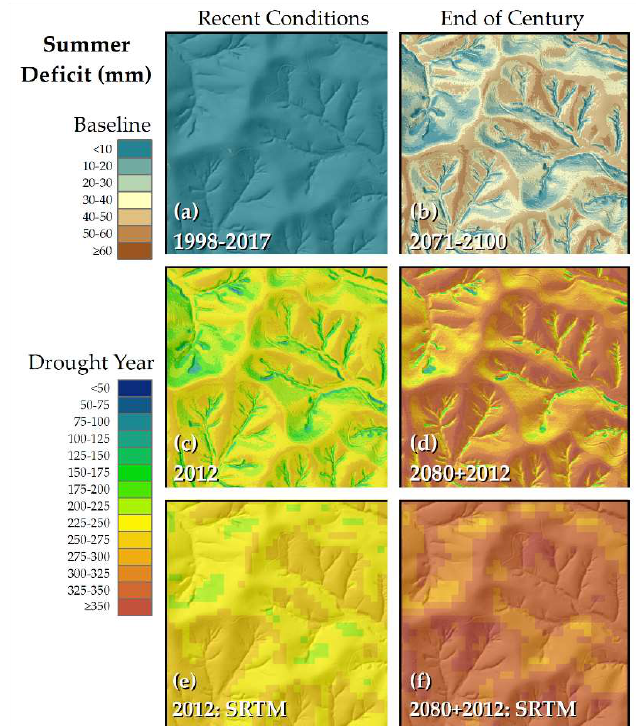
Figure 2. Modeled summer (JJA) water deficit for Lilly–Dickey Woods. Depicted area measures 900 m × 900 m, centered on the 25-ha ForestGEO plot. Left panels represent simulations of recent observed climatic conditions, right panels are comparable simulations for end-of-21st century climatic projections derived from the RCP8.5 radiative forcing scenario: ( a ) baseline conditions using average monthly values, 1998–2017; ( b ) baseline conditions with projected changes for 2071–2100 (“2080”); ( c ) drought year 2012; ( d ) projected future changes applied to 2012 values; ( e ) same historical simulation as ( c ) using NASA Shuttle Radar Topography Mission (SRTM) Digital Elevation Model (DEM); ( f ) same scenario as ( d ) using SRTM DEM. Light Detection and Ranging (LiDAR)-derived DEM used for ( a – d ); its hillshade projected over all images. Table 1. Descriptive statistics for summer [JJA] water deficit, precipitation (P), and potential evapotranspiration (PET) (units = mm), for water balance simulations depicted in Figure 2. The first three simulations utilize recent observed climatic conditions, the last three are based upon end-of-21 st century climatic projections derived from the RCP8.5 radiative forcing scenario.